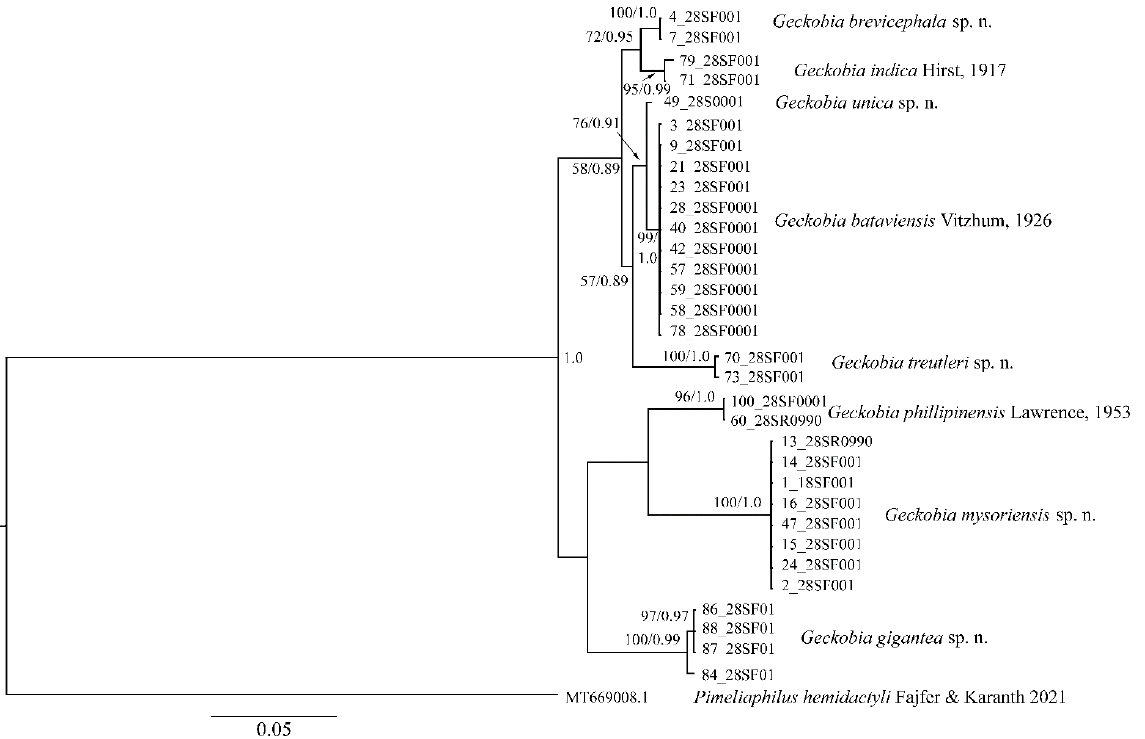
Figure 31. Maximum likelihood of 28S rRNA tree of the analysed Geckobia spp. Bayesian analysis yielded almost identical tree topology. The support of branches is given as bootstrap value for 1000 replications followed by posterior probability index.